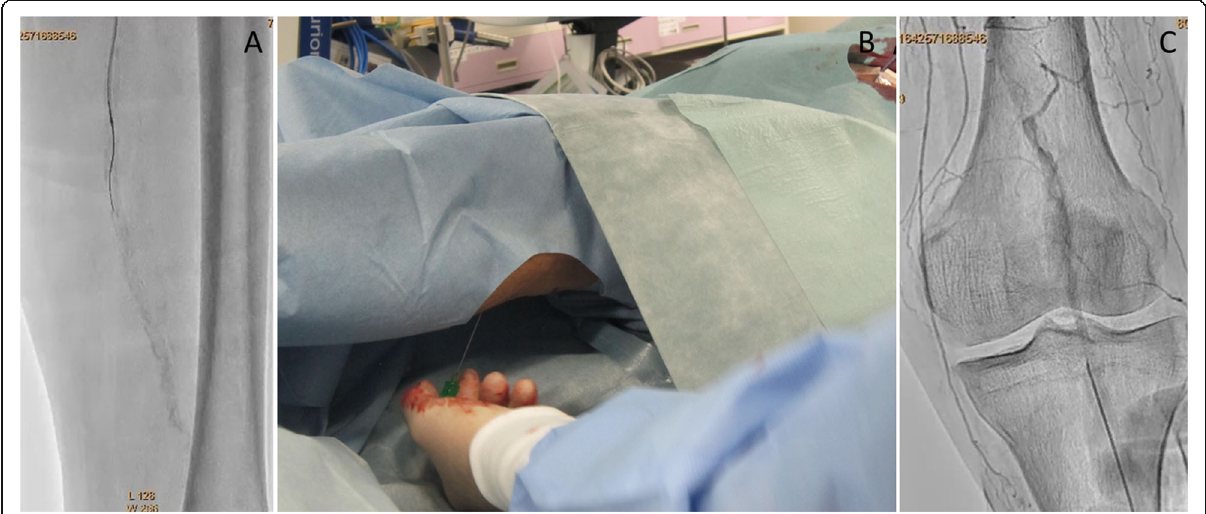
Fig. 2 a Antegrade wiring with heavy weight 0.014-in. tapered wire. Severe calcification prevents the advancement of antegrade wire into the lesion. b Retrograde popliteal puncture with the patient in the supine position. c : Puncture of the middle part of the popliteal artery under angiographic